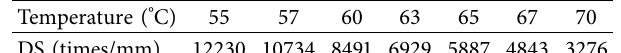
Table 3: Results of the